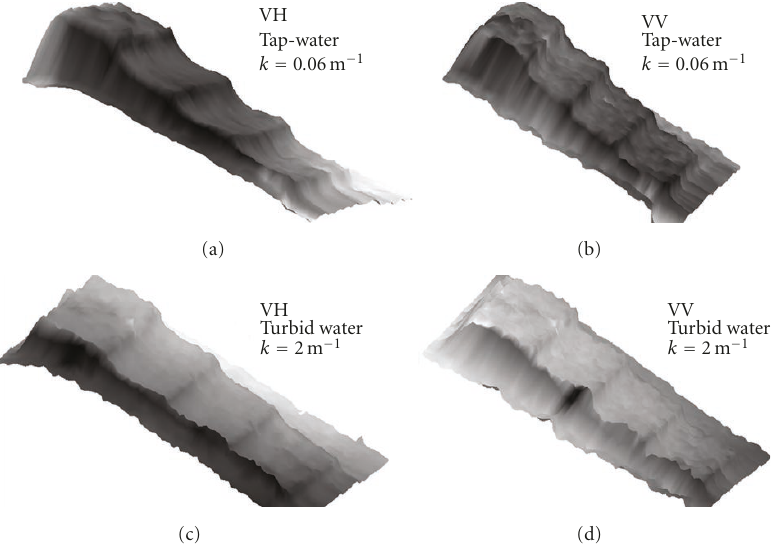
Figure 14: 3D images of the ladder, obtained by using cross-polarized (VH) and copolarized (VV) working schemes. The ladder was alternatively immersed in clean (tap water) and turbid water at 1.5 m from the